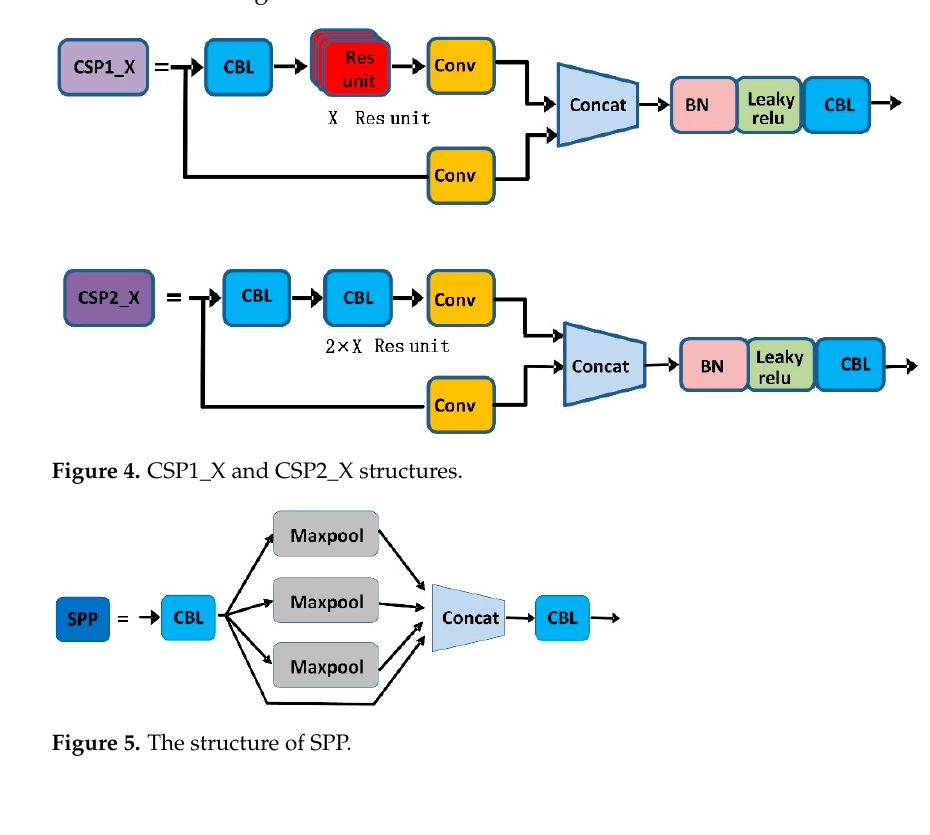
Figure 3. Focus slicing operation.